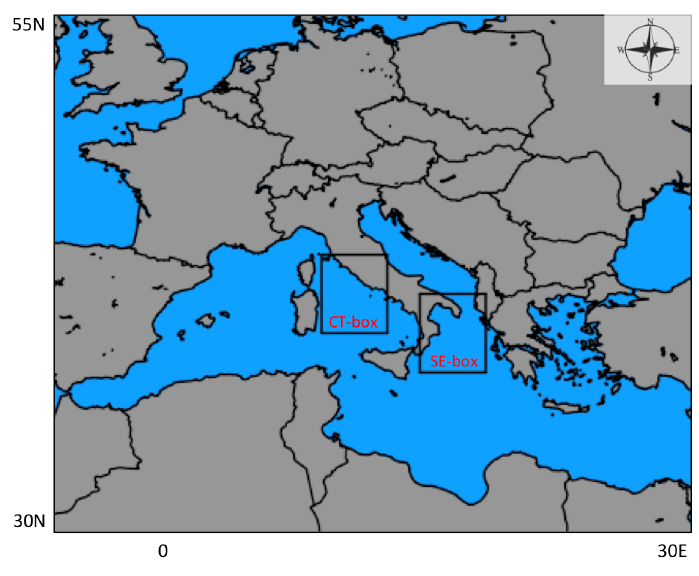
Figure A3. The two sub-boxes (namely CT-box and SE-box) in which the maximum values are